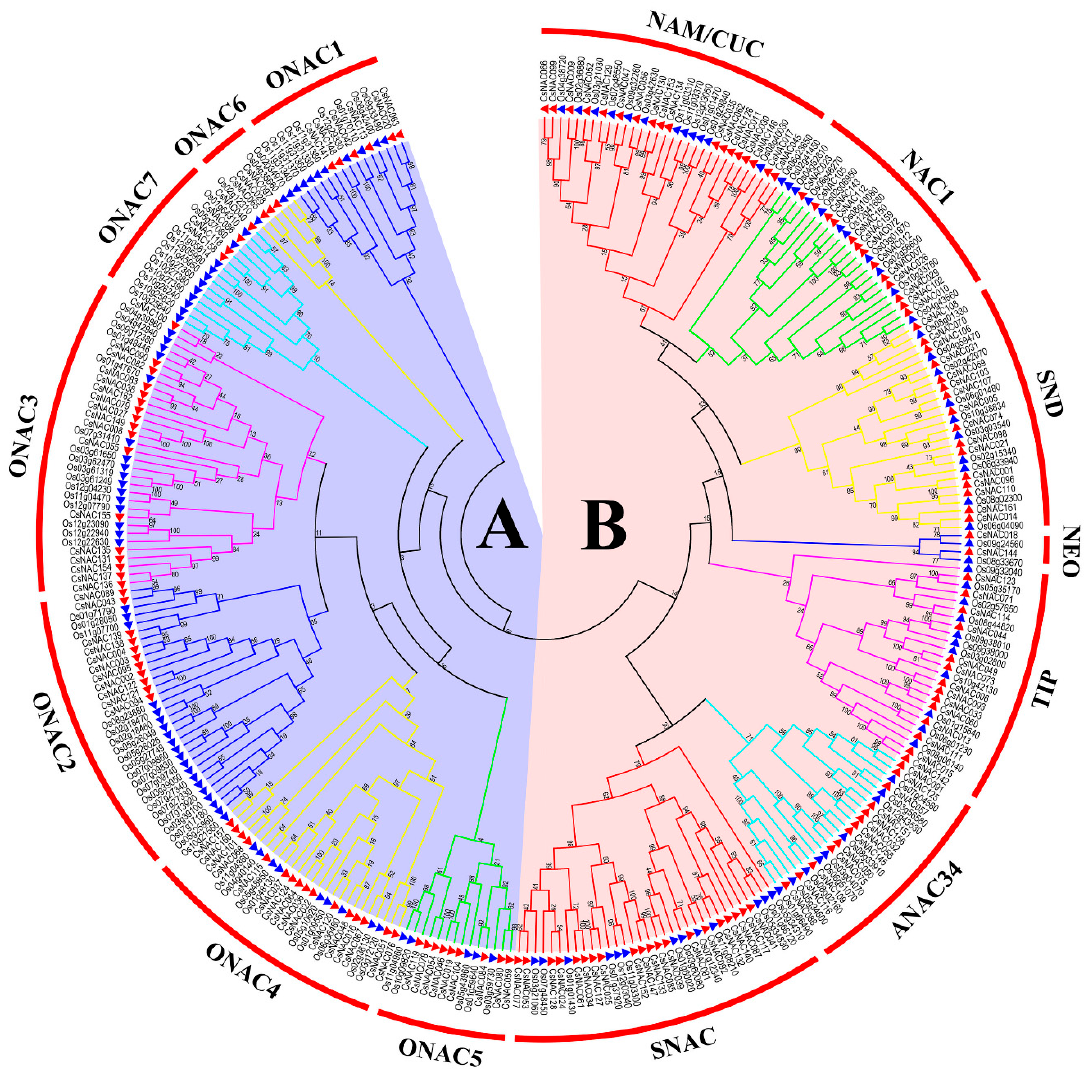
Figure 1. Phylogenetic tree of NAC transcription factors (TFs) in C. songorica and rice. The neighbor-joining (NJ) phylogenetic tree was constructed using the MEGA7 program with 1000 bootstrap replicates. CsNAC and OsNAC proteins were labeled by triangles with red and blue, respectively.